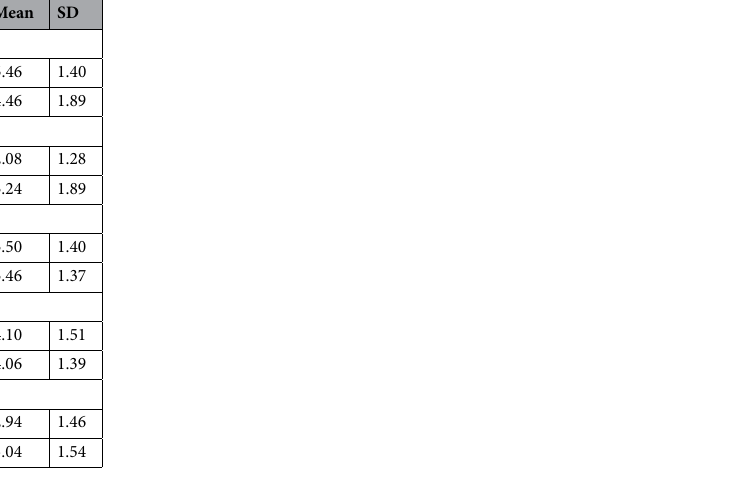
Table 4. Subjective memory ratings.